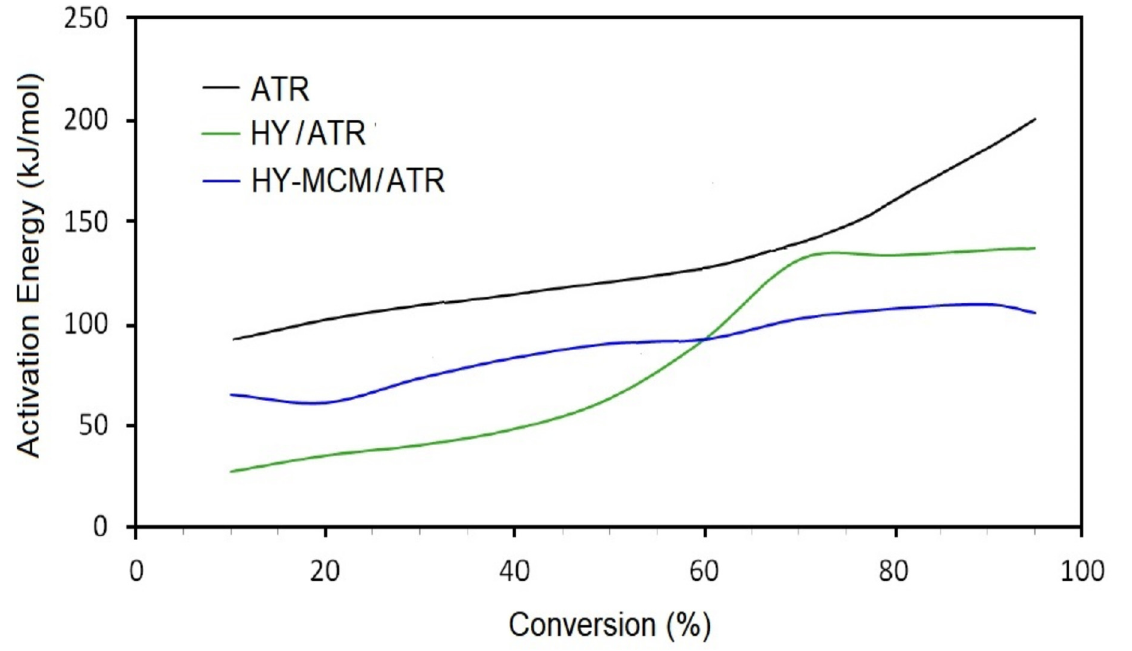
Figure 9. Activation energy as a function of degree of convention for the thermal and catalytic distillation of ATR, HY/ATR, and HY-MCM-41/ATR.